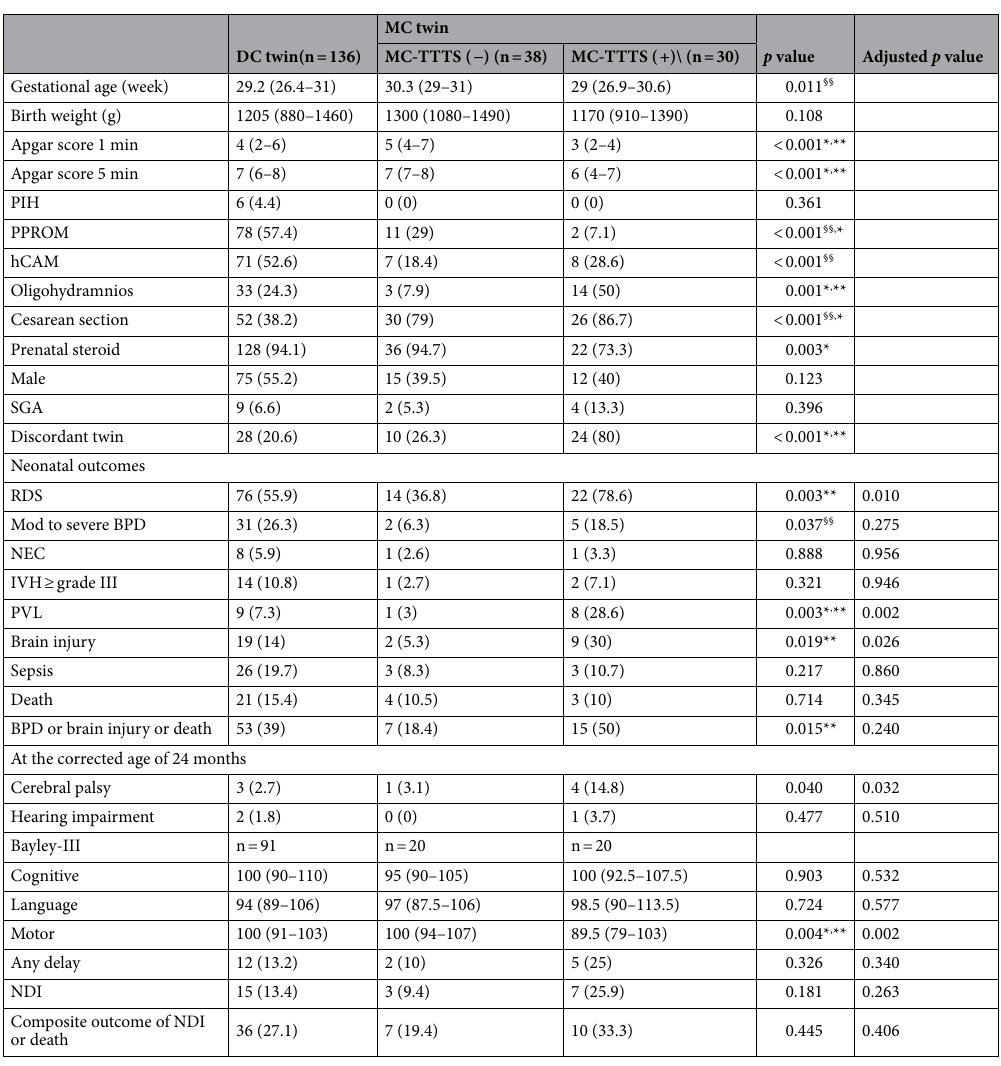
significant difference between DC twin and MC-TTTS ( −), * for significant difference between DC twin and MC-TTTS ( +), and ** for significant difference between MC-TTTS ( −) and MC-TTTS ( +) using Bonferroni correction or ad-hoc analysis (p < 0.017). DC Dichorionic, MC Monochorionic, TTTS Twin- to-twin transfusion syndrome, PIH Pregnancy-induced hypertension, PROM Preterm premature rupture of membrane, hCAM Histologic chorioamnionitis, SGA Small for gestational age, RDS Respiratory distress syndrome, BPD Bronchopulmonary dysplasia, NEC Necrotizing enterocolitis, Bayley-III, Bayley scales of infant and toddler development 3rd edition, NDI Neurodevelopmental impairment. Brain injury was defined as an intraventricular hemorrhage of grade ≥ 3 or periventricular